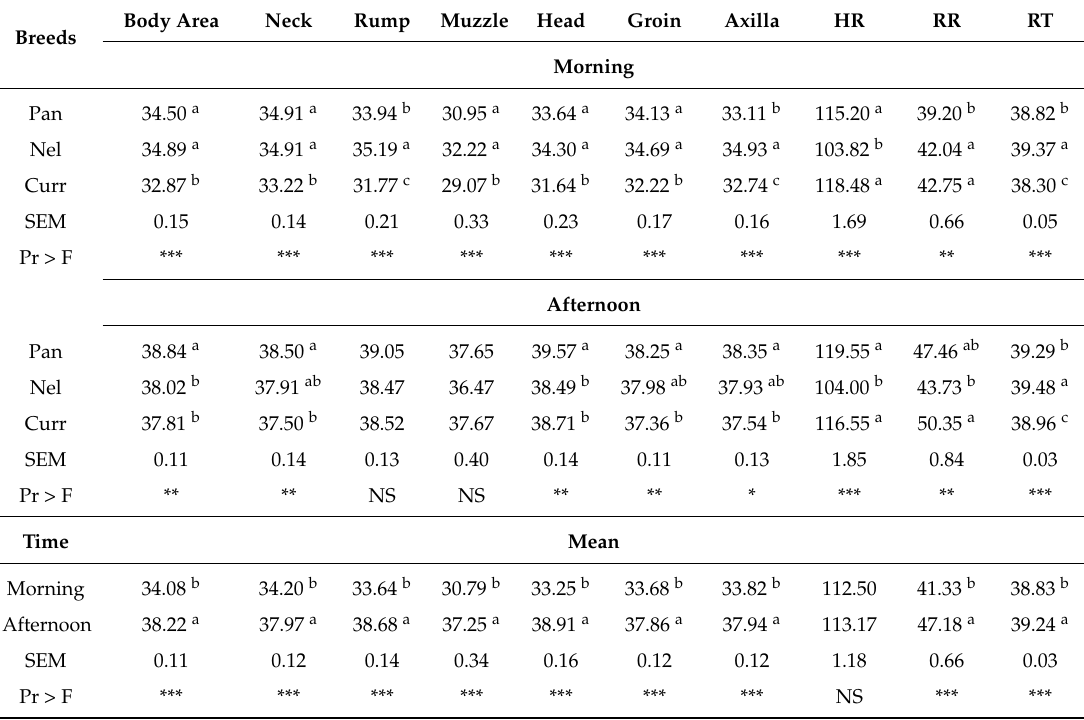
Table 2. Surface temperatures and physiological parameters of the breeds in the morning and afternoon.